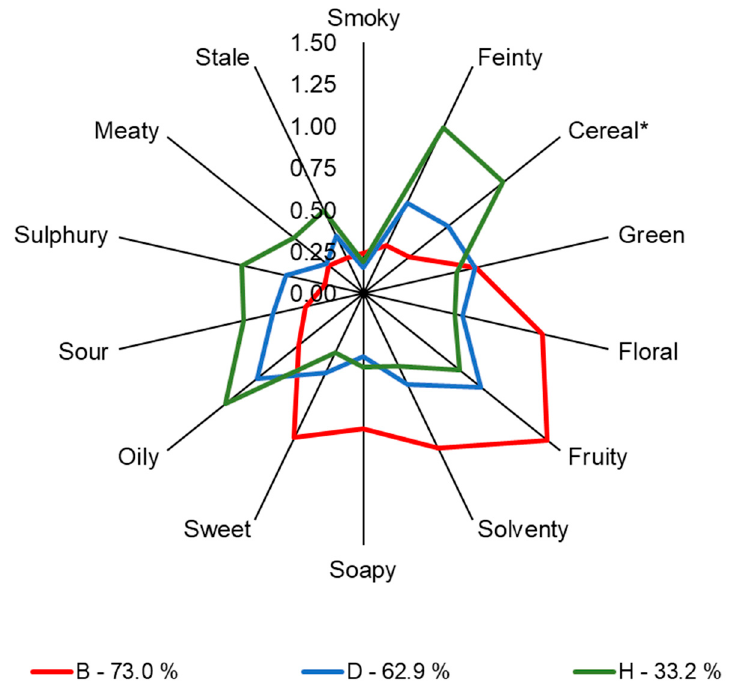
Figure A1. Typical presentation of QDA mean panel scores in a spider diagram for three selected spirits. * displays significant differences ( p < 0.05).